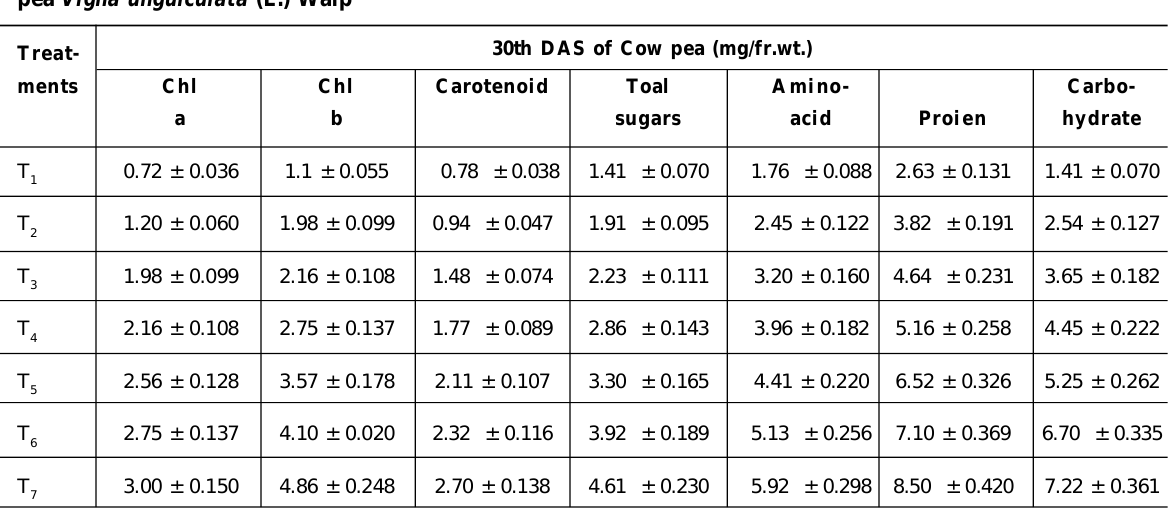
Table 2: Effects of different microbial fertilizers on the biochemical content of cow pea Vigna unguiculata (L.) Walp Treat- 30th DAS of Cow pea (mg/fr.wt.) ments Chl Chl Carotenoid Toal Amino-